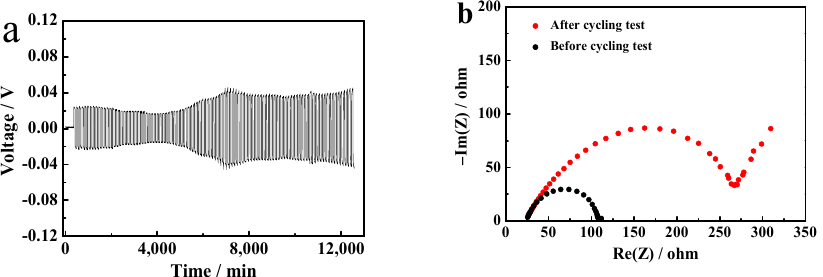
Figure 8. ( a ) The charge and discharge cycling measurement and ( b ) EIS results of Li | Li symmet- rical cell with TLPEC electrolyte: constant current (0.1 mA cm − 2 ) for 60 min; 100 cycles at 25 °C.